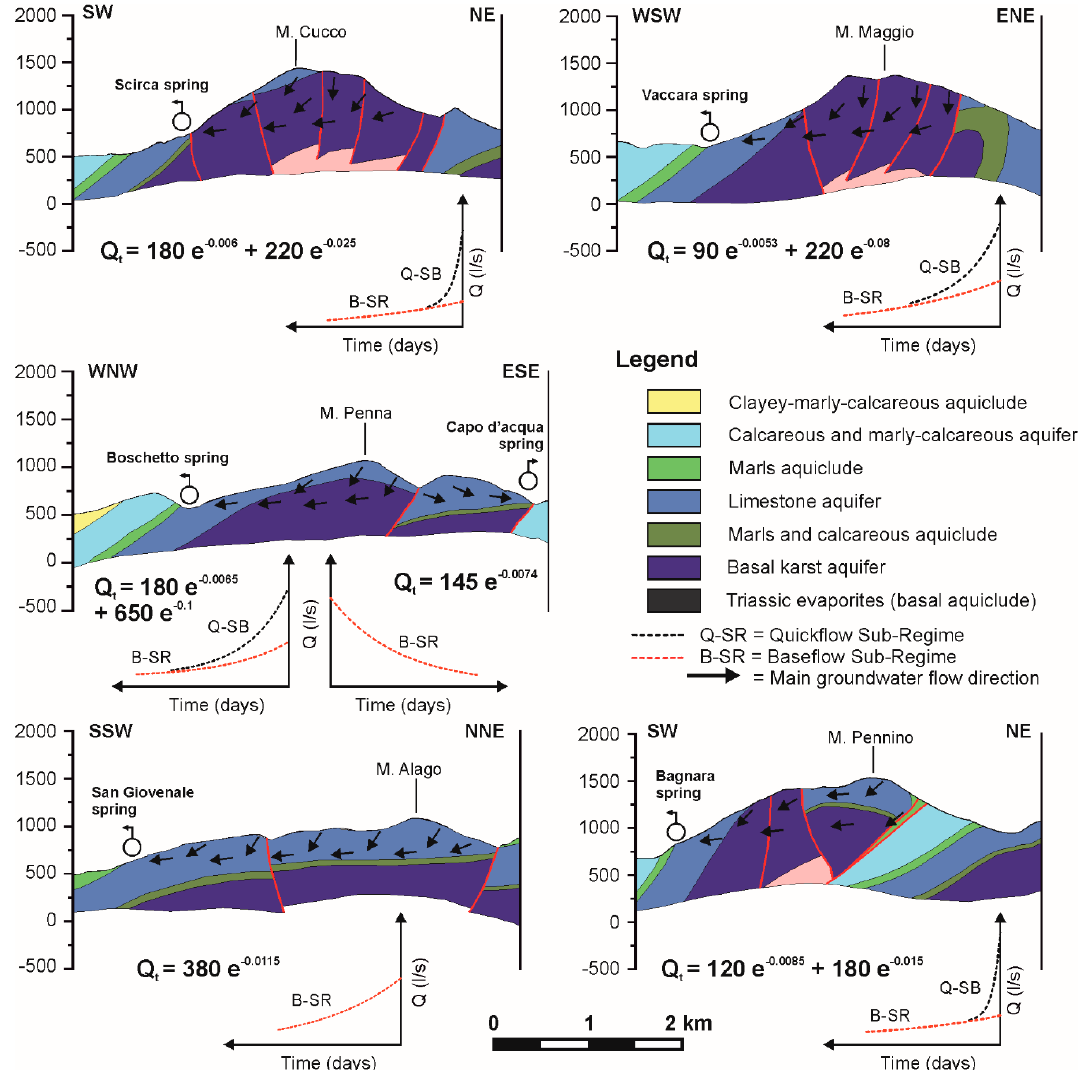
Figure 8. Geological sketch of flow dynamics in the carbonate hydrostructures: geological cross-section, graphics of recession curves (MRC analysis), and their relative equations describing karst spring discharge.